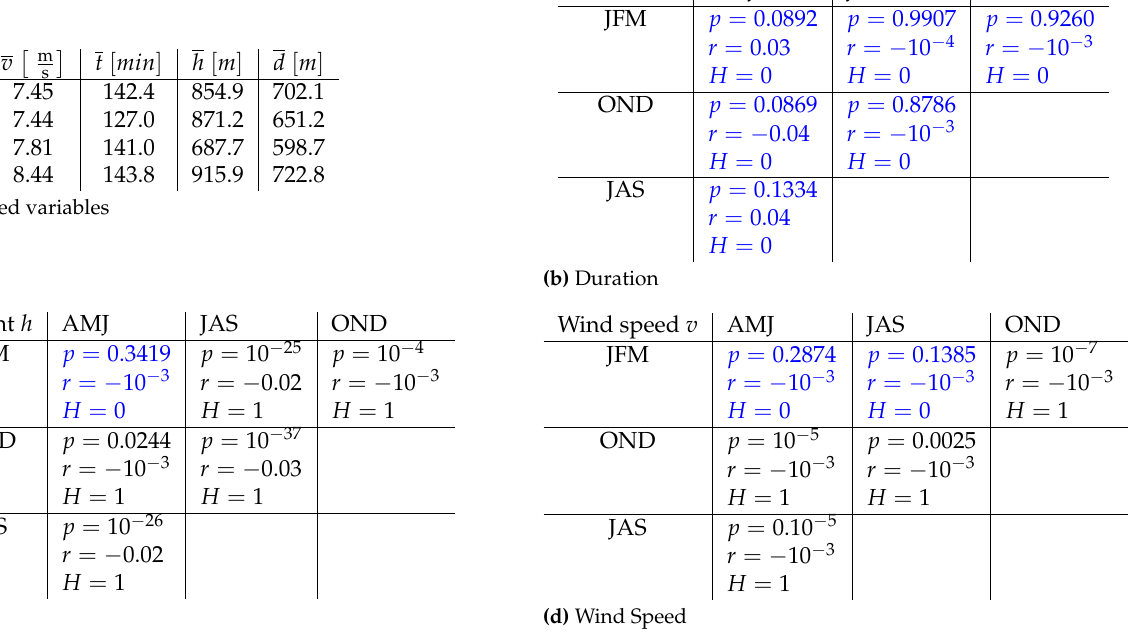
Table 3. seasonal averages of the variables (3a) as well as seasonal correlation of duration (3b), height (3c) and wind speed (3d). p is the significance level of the Mann–Whitney U test, with H = 0 the null hypothesis cannot be rejected (values are marked in blue), and H = 1 the null hypothesis can be rejected. The Pearson correlation coefficient, r , is also given for all of the variables. Duration t